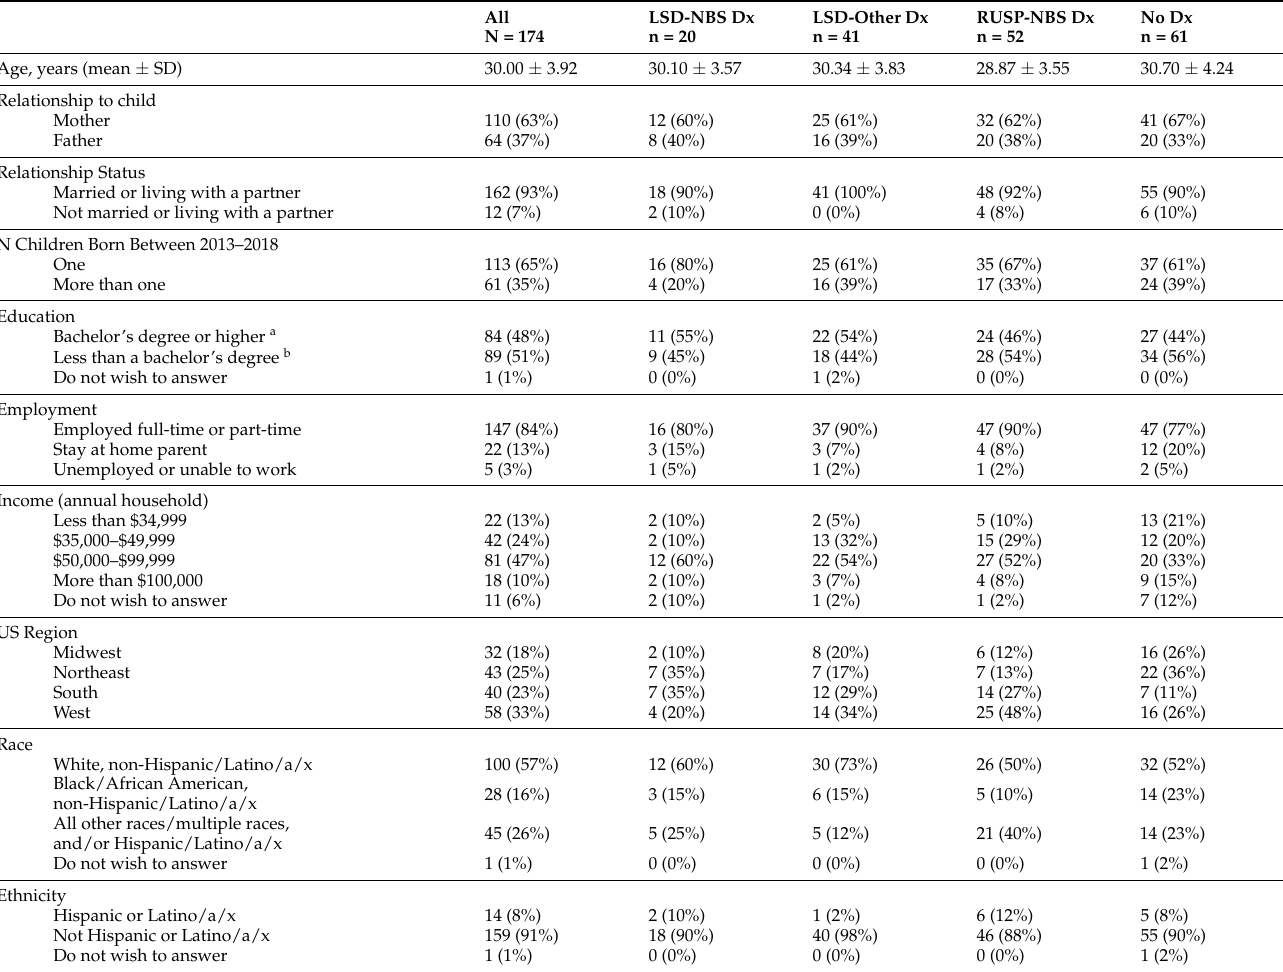
Table 1. Sociodemographic characteristics of parents who participated in the